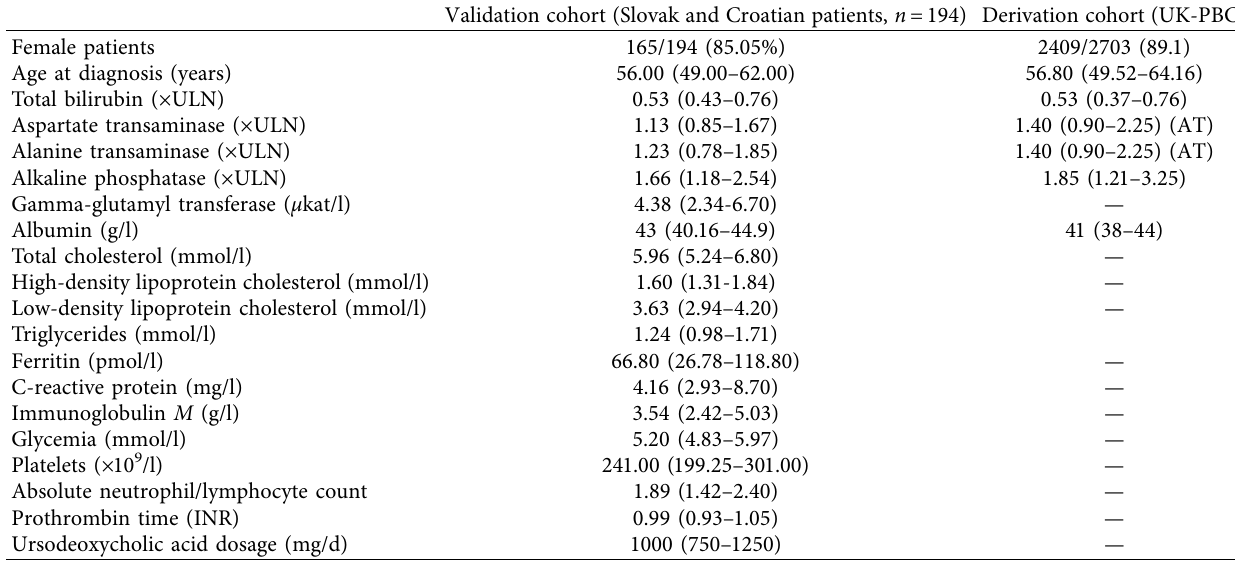
Figure 1: Flowchart of patient recruitment. Table 1: Baseline clinical and demographic characteristics of both Slovak and Croatian and derivation